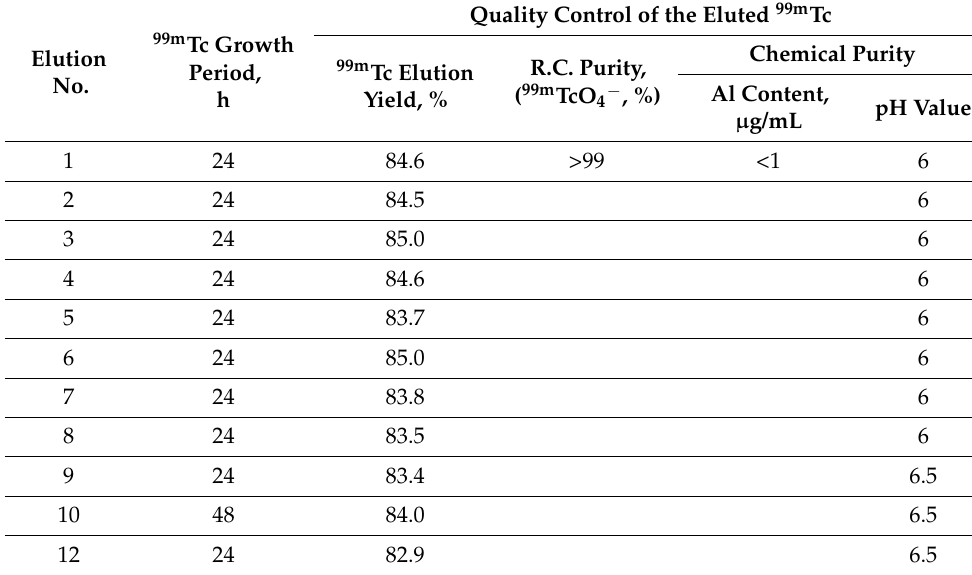
Table 3. The elution yield and quality control data of 99m Tc eluates.